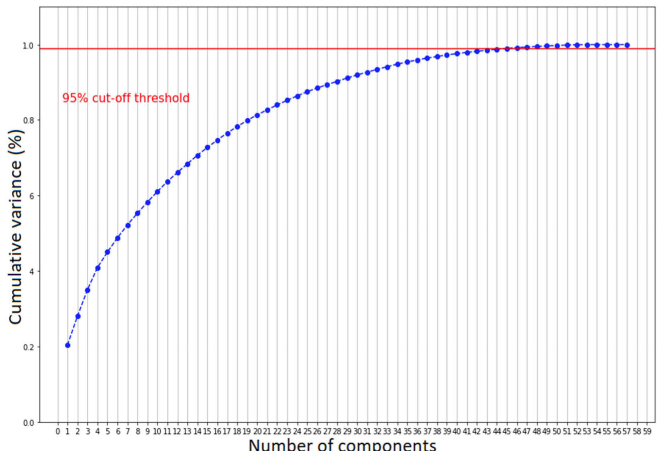
Figure 4. The number of components needed to explain 95% of statistical